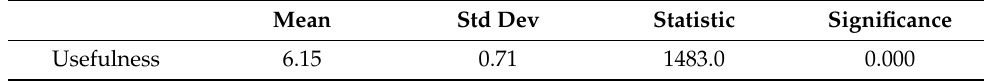
Table 10. Wilcoxon signed rank tests.